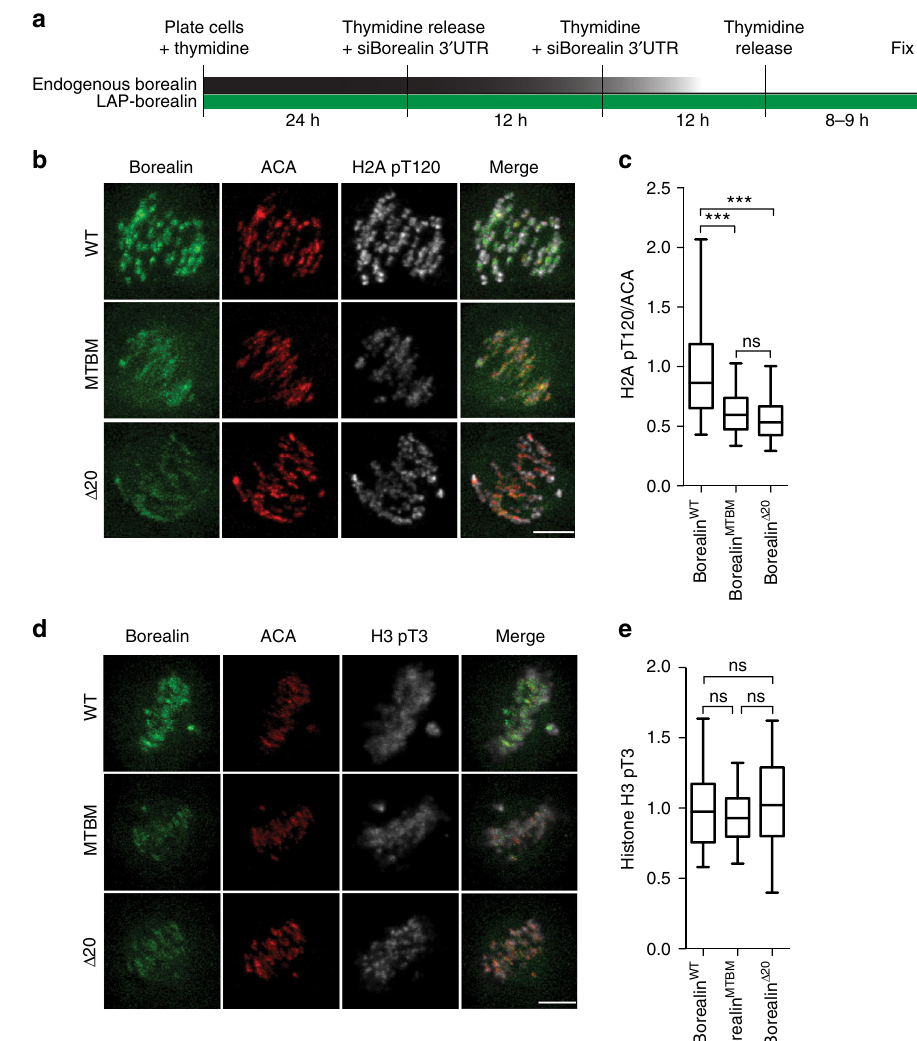
Fig. 7 Borealin-microtubule interaction enhances kinetochore sub-network of the CPC inner-centromere localization pathway. ( a ) Schematic of Borealin siRNA mediated knockdown rescue experiment. ( b , d ) HeLa-TReX cells stably expressing LAP-Borealin WT or MTBM or Δ 20 were treated as in a and immunostained with histone H2a pT120 and H3 pT3 antibodies. c Box and whisker graph of histone H2a pT120 intensity normalized by ACA intensity ( n = 166 (from 13 cells) for WT, n = 223 (from 16 cells) for MTBM, and n = 150 for Δ 20 (from12 cells)). d Box and whisker graph of histone H3 pT3 intensity ( n = 188 (from 16 cells) for WT, n = 200 (from 15 cells) for MTBM, and n = 100 (from 10 cells) for Δ 20). Statistical analysis was performed using one-way ANOVA (Kruskal – Wallis test) with Dunn's Multiple Comparison Test, *** P < 0.001; ** P < 0.01, * P < 0.05 and ns P > 0.05. All representative images and quantitation are from one of two independent replicates. All Box and whisker plots represent the median (central line), 25th – 75th percentile (bounds of the box) and 5th – 95th percentile (whiskers). Scale bar is 5 μ